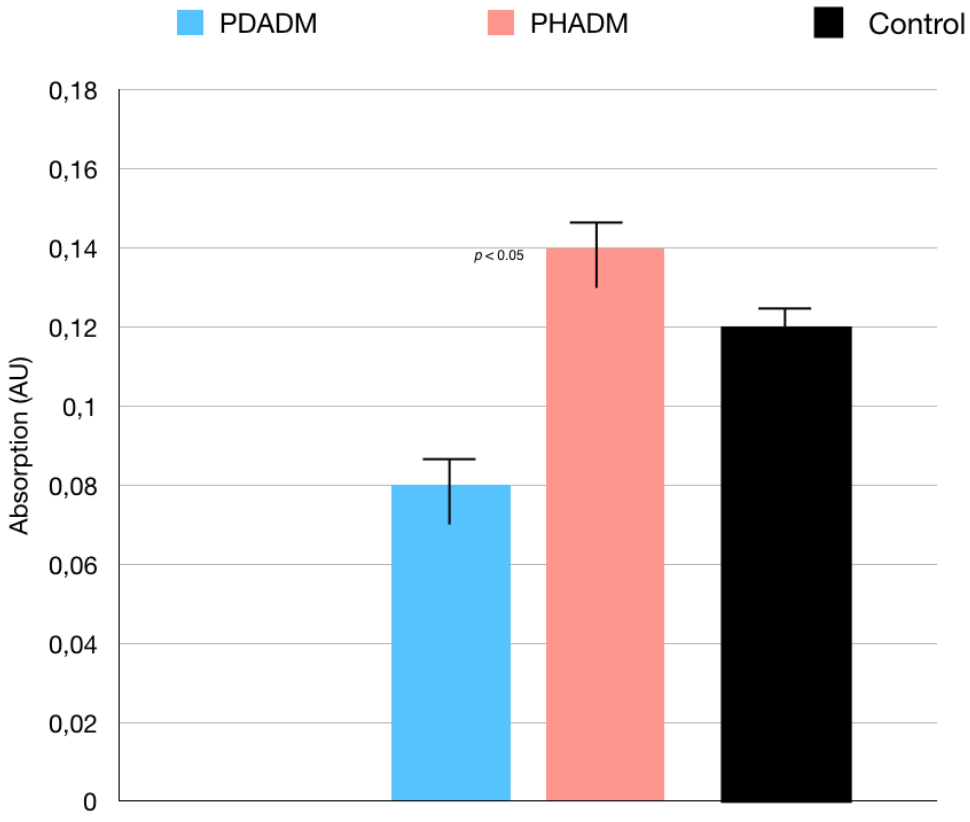
Figure 1. Results of the WST test of HPMSCs directly cultured onto matrices after 7 days. Cells seeded on cover glass served as controls. Each column shows the results of experiments repeated three times. (One-way analysis of variance (ANOVA) with Tukey’s post-hoc test. Values of p < 0.05 were considered significant.)